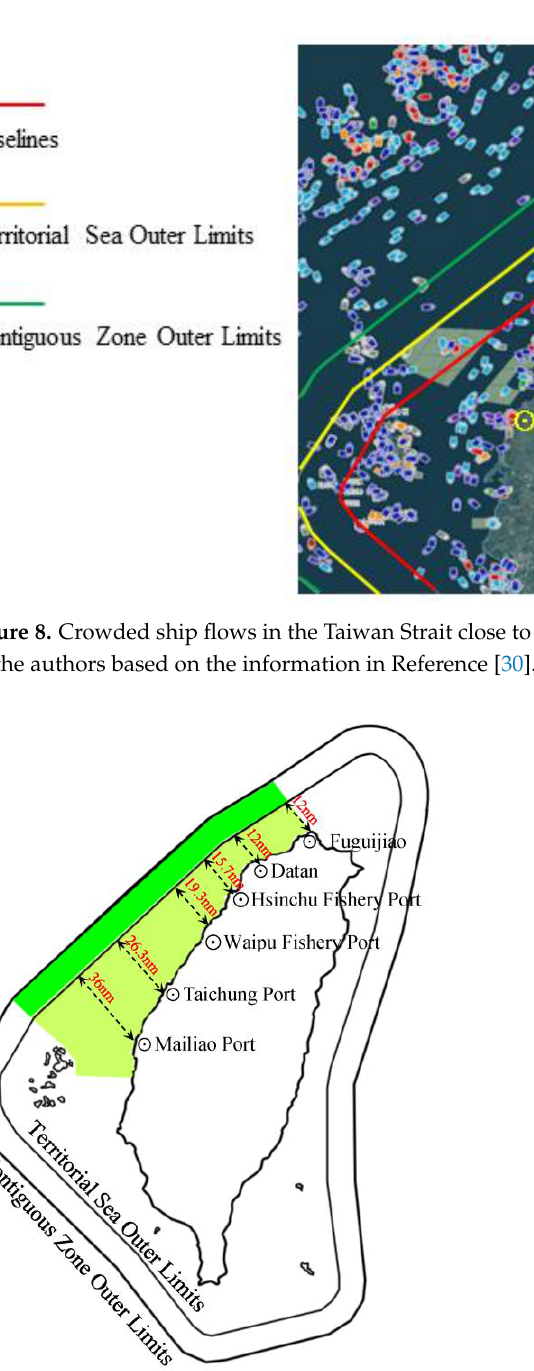
Figure 9. Width variations of the navigation channel within the offshore wind farm off of Taiwan’s western coast. Source: plotted by the authors.